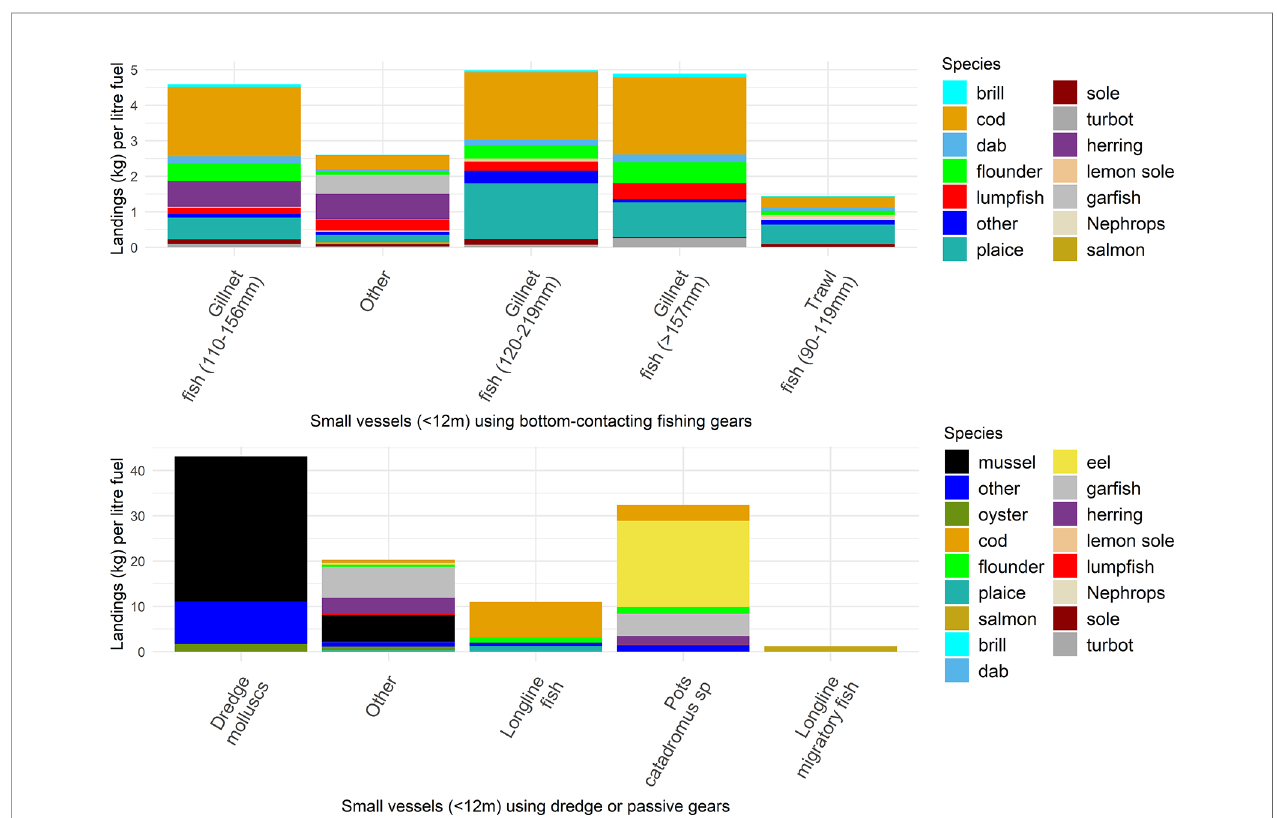
FIGURE 7 | Landings (kg) per litre of fuel consumed (CPUF) per fl eet-segment across species for small vessels (<12 m). Fleet segments are ordered from left to right by landing volume. The overall fuel use intensity estimates are sectored per species depending on their contribution to the total landing for each fl